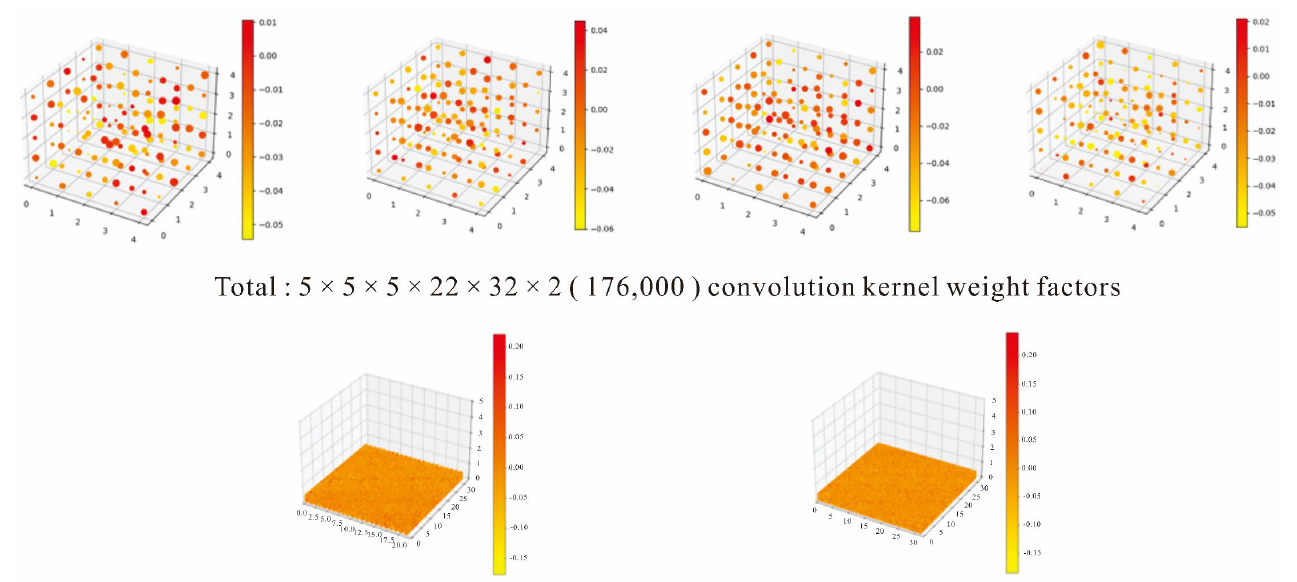
Figure 12. The output of the convolution kernel under the 3D CNN transfer learning in the Minle mining area.